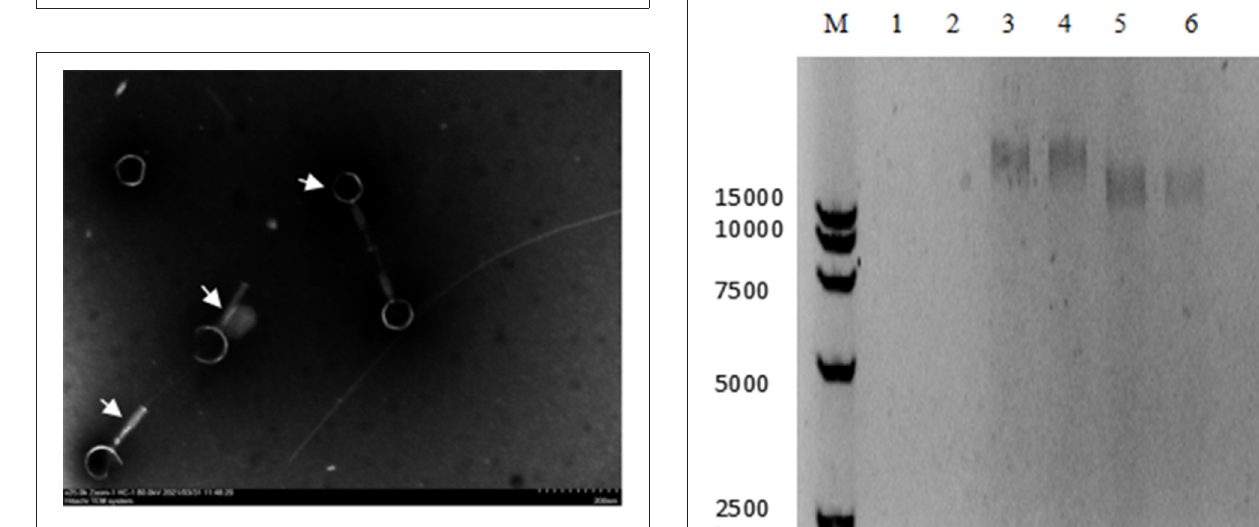
FIGURE 2 | Transmission electron microscopy (TEM) image of LP8. White arrows in the figure indicate phage. The phage has a hollow needle-like structure; the tail consists of an envelope and the base consists of a tail needle. The average diameter of the phage head is 80nm and the average length of the tail is 120nm. Scale bar: